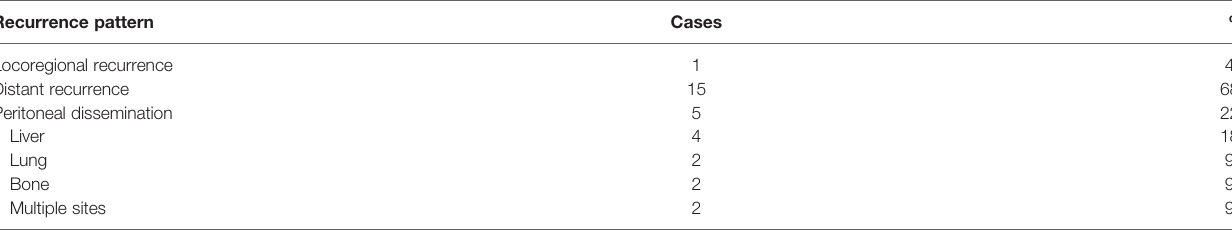
TABLE 2 | Pattern of recurrence.